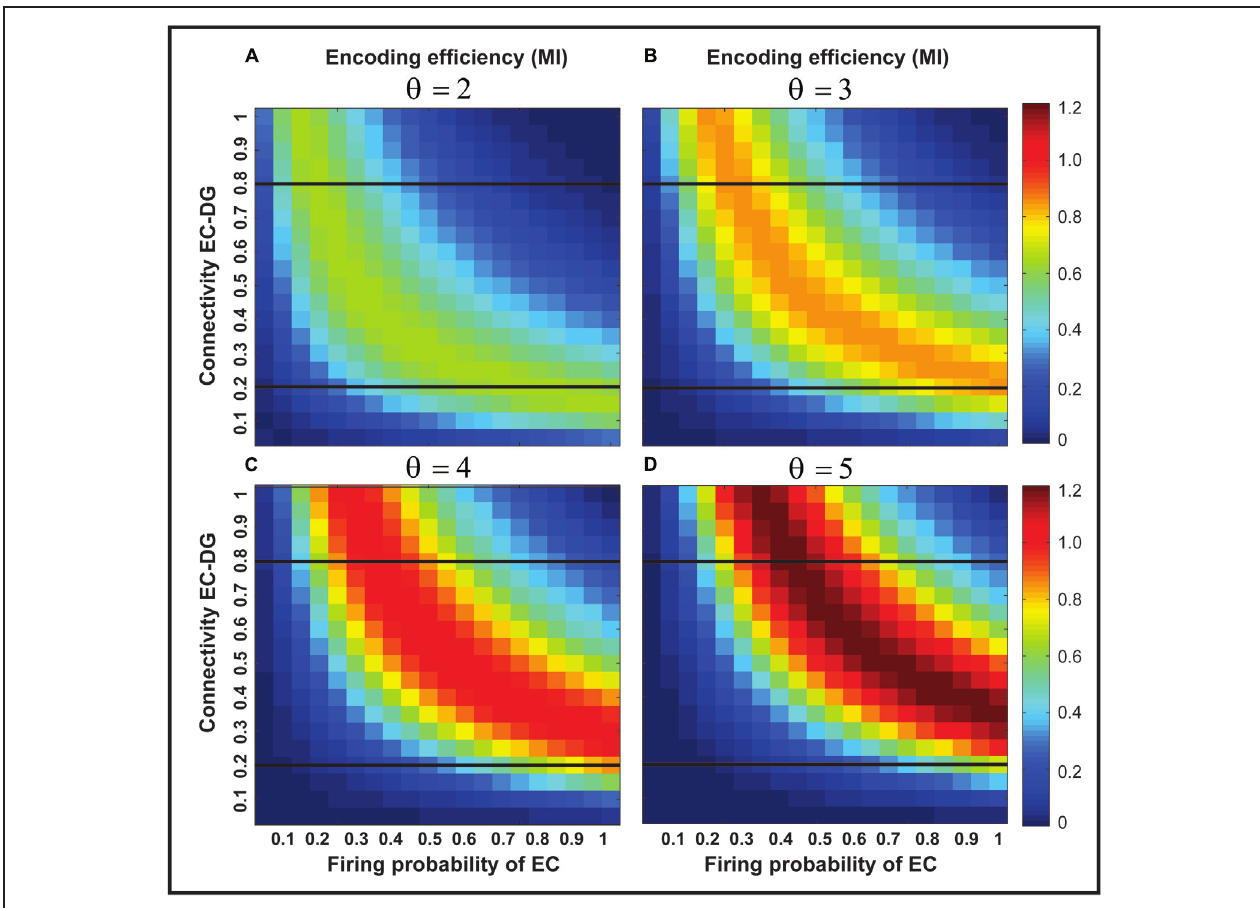
FIGURE 3 | Mutual information for different parameters values. Mutual information is calculated for a connectivity rate between the EC and the single neuron, firing probability of activated neurons in the neural layer and firing threshold of the single neuron between 2 and 5 (A–D) .